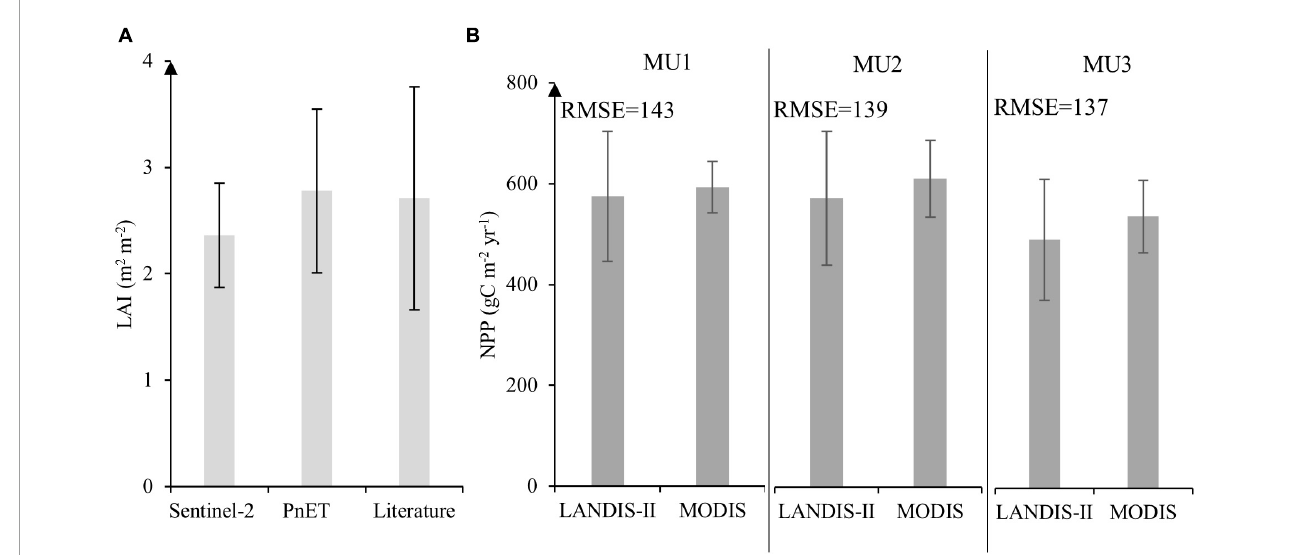
FIGURE3 (A) Comparison for MU1 between monthly LAI during the growing season per unit ground surface area (m 2 m - 2 ) at landscape scale of PnET succession in 2020 with Sentinel-2 and literature values. (B) Model validation through annual NPP estimated by MODIS imagery and the predicted data from LANDIS-II. The error bar presents the standard deviation at a significance level of 0.05.